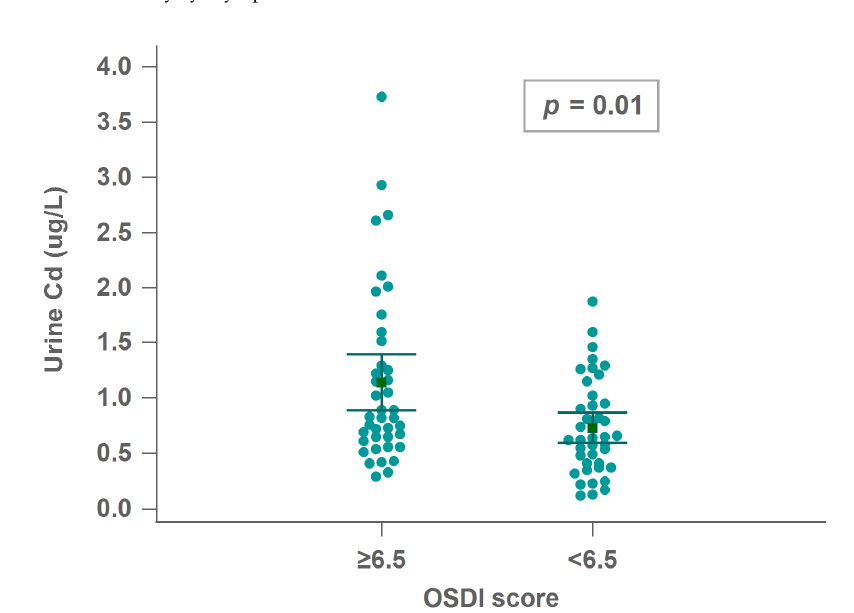
Figure 2. Multiple comparison graph of urinary Cd and OSDI scores. Abbreviations: OSDI, ocular surface disease index; Cd, cadmium.